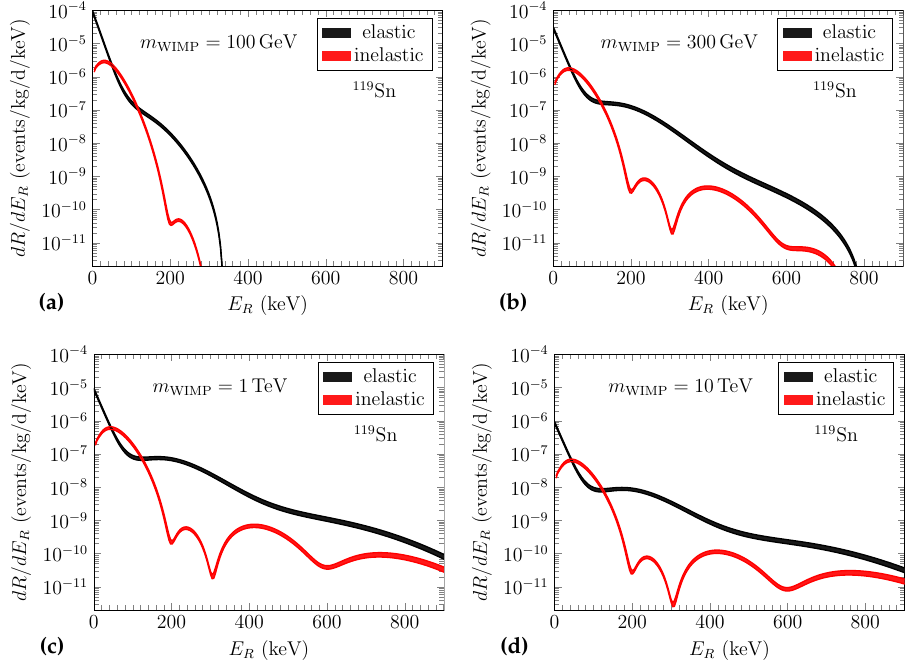
Figure 4. Differential event rates in 119 Sn with WIMP masses: ( a ) 100 GeV; ( b ) 300 GeV; ( c ) 1 TeV; and ( d ) 10 TeV.